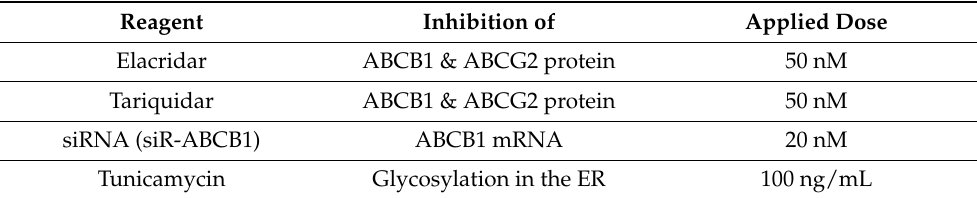
Table 2. Applied doses and targets of inhibition of small molecule inhibitors and siRNA used in this